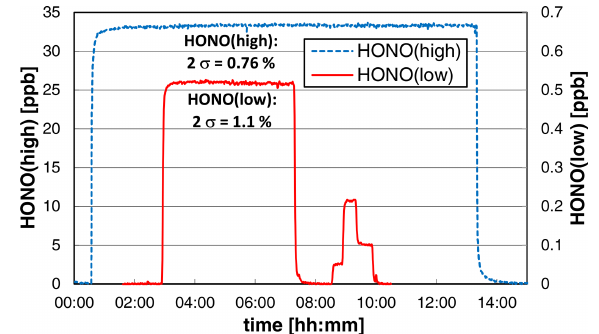
Figure 8. Stability tests of the HONO source at different HONO mixing ratios. On the left axis the chemiluminescence = 0.8mgL − 1 , 2 = 0.8mgL − 1 , data of a high-concentration experiment (NO − 2 ∅ , dry = 1570cm 3 min − 1 , 10rpm, pH = 2.47) T = 15.9 ◦ C, φ g and on the right axis the LOPAP data at lower concentra- = 0.01 (0.001/0.004/0.002)mgL − 1 , T = 15.9 ◦ C, tions (NO − 2 ∅ , dry = 2104cm 3 min − 1 , 20rpm, pH = 2.54) are shown. For φ g zero measurements the source was operated under